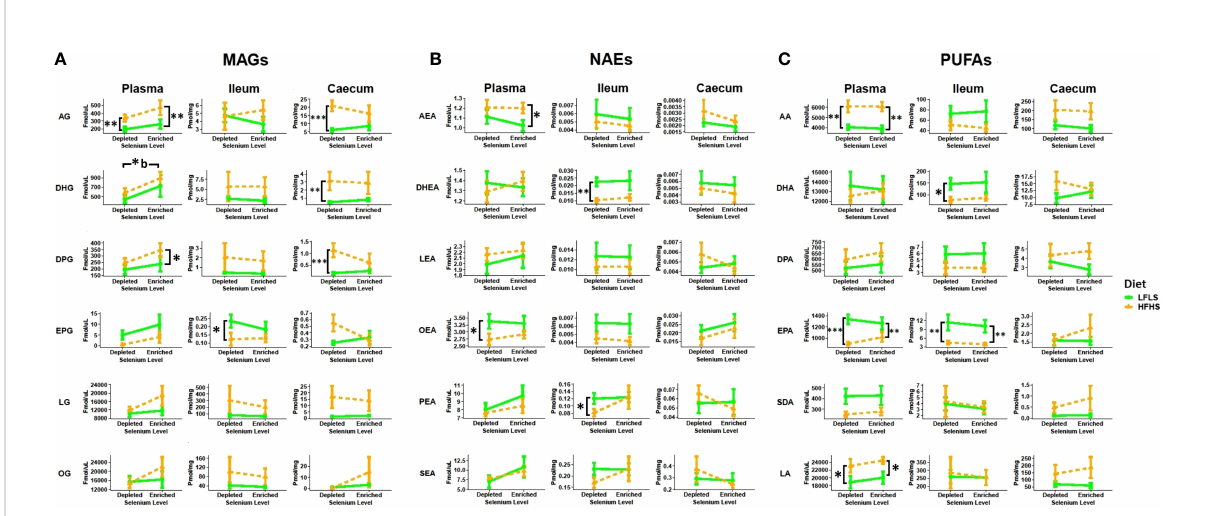
FIGURE 3 Diet and Se modulation of the endocannabinoidome and fatty acid precursors. A ) 2-monoacylglycerols (2-MAGs), B ) N -acylethanolamines (NAEs) and C ) long chain w -6 and w -3 polyunsaturated fatty acid (PUFA) response to Se-enriched and Se-depleted LFLS or HFHS diets. Line chart representation of the eCBome mediators in Plasma, Ileum and Caecum. Data are expressed as the mean ± SEM (n=12). P values of linear contrast analysis are detailed when signi fi cant ‘ *** ’ P < 0.001, ‘ ** ’ , P < 0.01, ‘ * ’ , P<0.05 using contrast test between enriched and depleted Se levels, LFLS and HFHS formulations and the combination between Se levels and formulations. Letter b indicates difference between HFHS conditions. The samples were analysed at day 28 of the